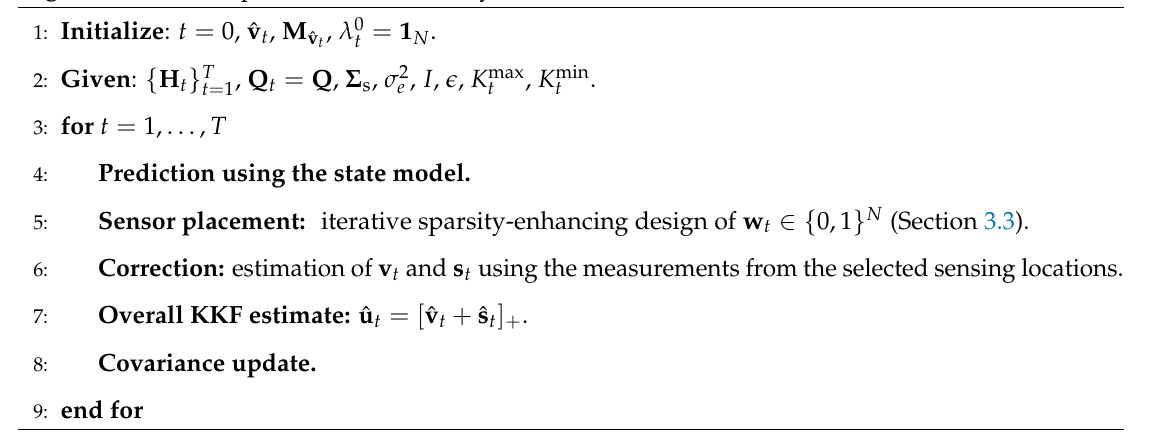
Algorithm 1 Sensor placement followed by a KKF